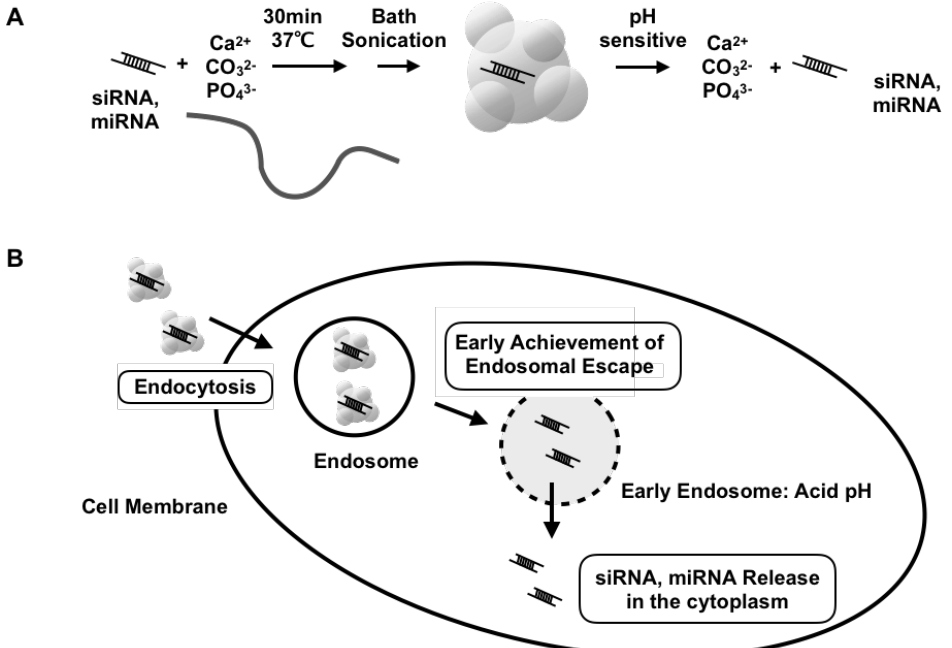
Figure 1. Schematic presentation of sCA-siRNA/miRNA. ( A ) Production of sCA nanoparticles involves mixing inorganic ions (CO 32 − , Ca 2+ , and PO 43 − ) with siRNA or miRNA and incubating at 37 °C for 30 min. After bath sonication, the sCA nanoparticles can be degraded at acidic pH to release the incorporated siRNA/miRNA compounds. ( B ) sCA nanoparticles enter the cell via endocytosis and are degradable in the acidic pH of endosomes, indicating quick achievement of endosomal escape.